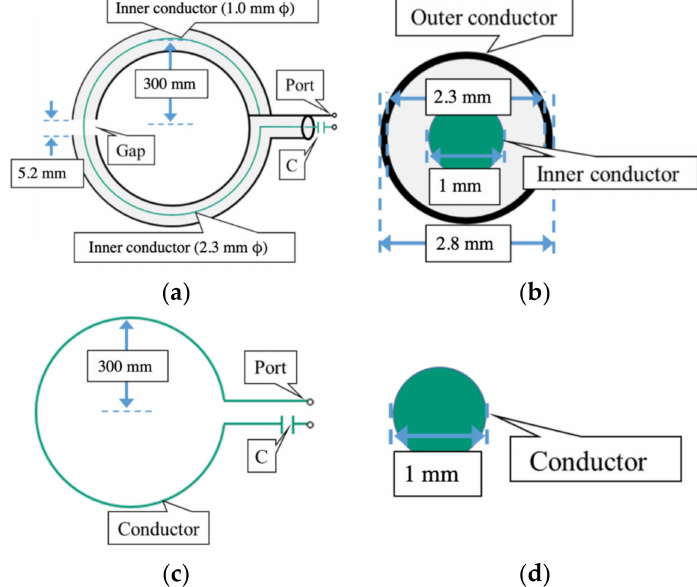
Figure 1. Schematic explanation of a shielded loop coil. ( a ) Overall view of a shielded loop coil, ( b ) sectional view of a shielded loop coil, ( c ) overall view of a one-turn loop coil, and ( d ) sectional view of a one-turn loop